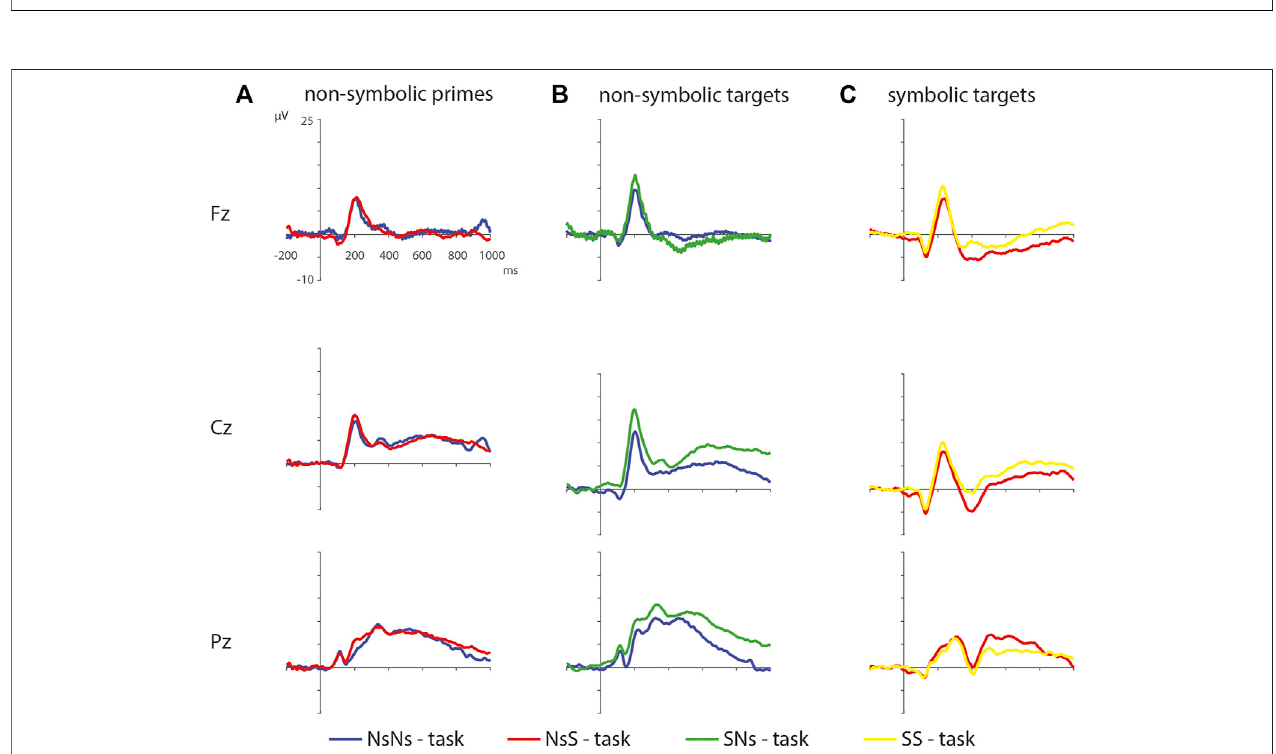
FIGURE 8 | ERPs of the non-symbolic primes in the NsNs-task and the NsS-task (A) , the non-symbolic targets in the NsNs-task and the SNs-task (B) , and the symbolic targets in the NsS-task and the SS-task (C) .